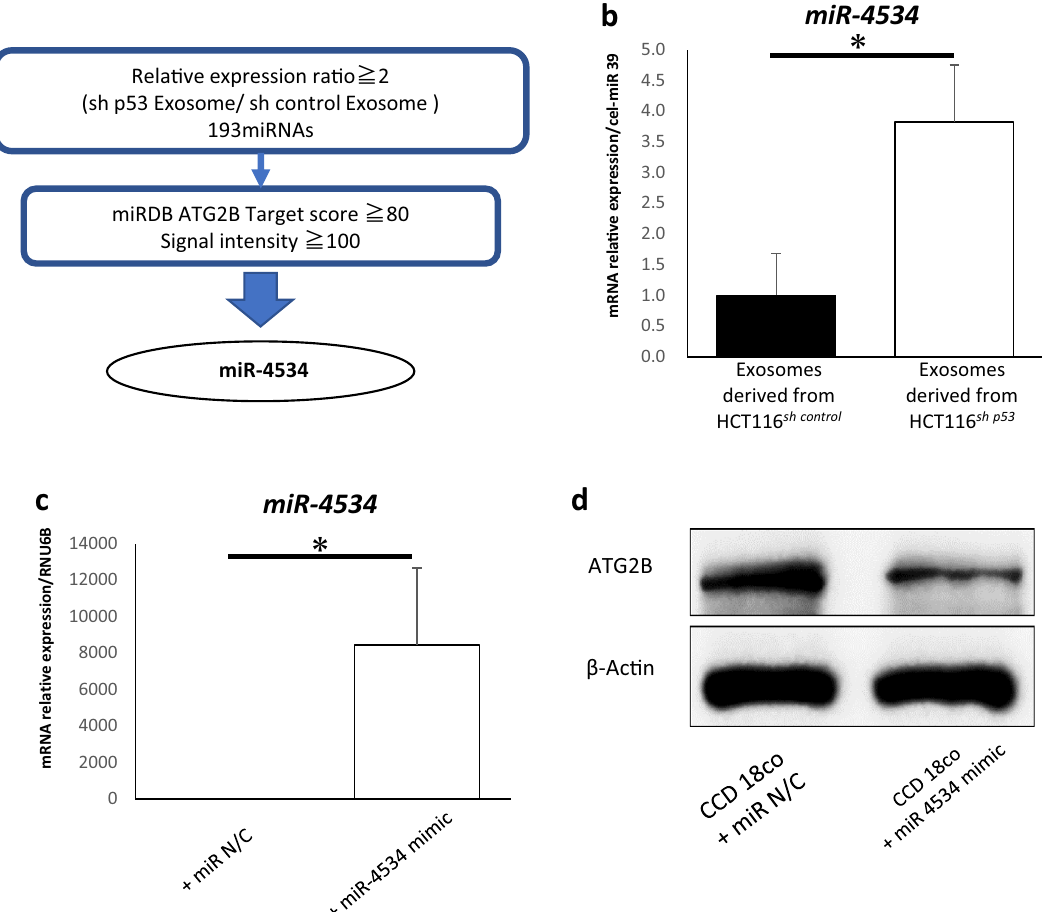
Figure 5. miR-4534 inhibits ATG2B expression in fibroblasts. ( a ) Strategy for identifying miR-4534 using microarray analysis and miRDB. ( b ) The relative expression levels of miR-4534 in exosomes derived from HCT116 sh control and HCT116 sh p53 cells analysed using quantitative real-time PCR (qRT-PCR) ( n = 4, mean ± SD, *P < 0.05). ( c ) Relative expressions of miR-4534 in CCD-18Co cells transfected with or without miR-4534 mimics analysed using qRT-PCR ( n = 5, mean ± SD, *P < 0.05). ( d ) Western blotting analysis of ATG2B in CCD-18Co cells transfected with or without miR-4534 mimics. ( e ) Western blotting and autophagic flux assays in CCD-18Co cells transfected with or without miR-4534 mimics ( n = 4, mean ± SD, *P < 0.05). ( f ) Relative expressions of FGF2, PDGFA, ACTA2, CXCL12, TGFβ1 , and VEGFA mRNAs in CCD-18Co cells transfected with or without miR-4534 mimics analysed using qRT-PCR ( n = 3, mean ± SD, *P < 0.05). Protein expression levels were measured using imageJ software 1.8.0_172 (https:// imagej. nih.